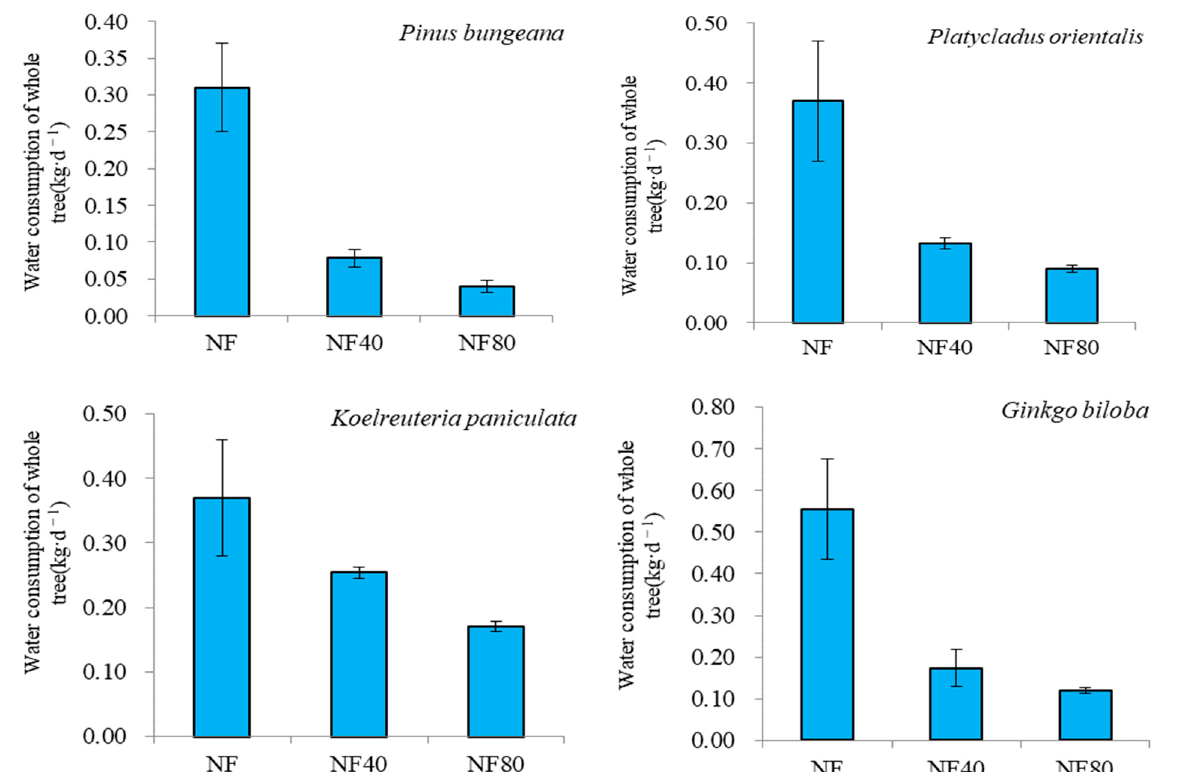
Figure 2. Variation of water consumption of whole trees under different ozone